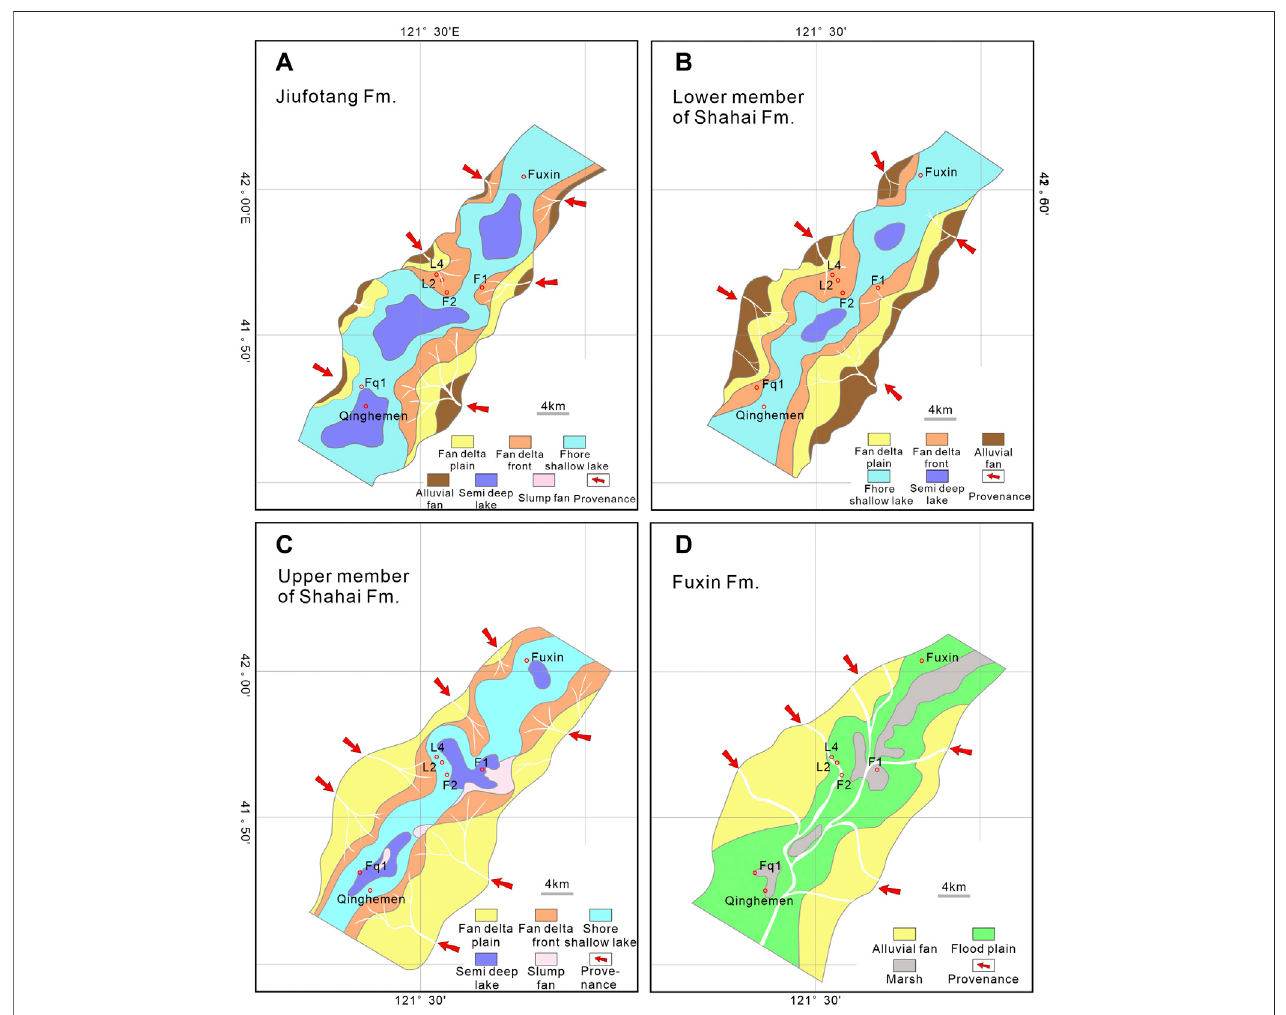
FIGURE 8 | Sedimentary facies of the formations of the Fuxin Basin. (A) Jiufotang Formation. (B) First member of the Shahai Formation. (C) Fourth member of the Shahai Formation. (D) The Fuxin Formation.